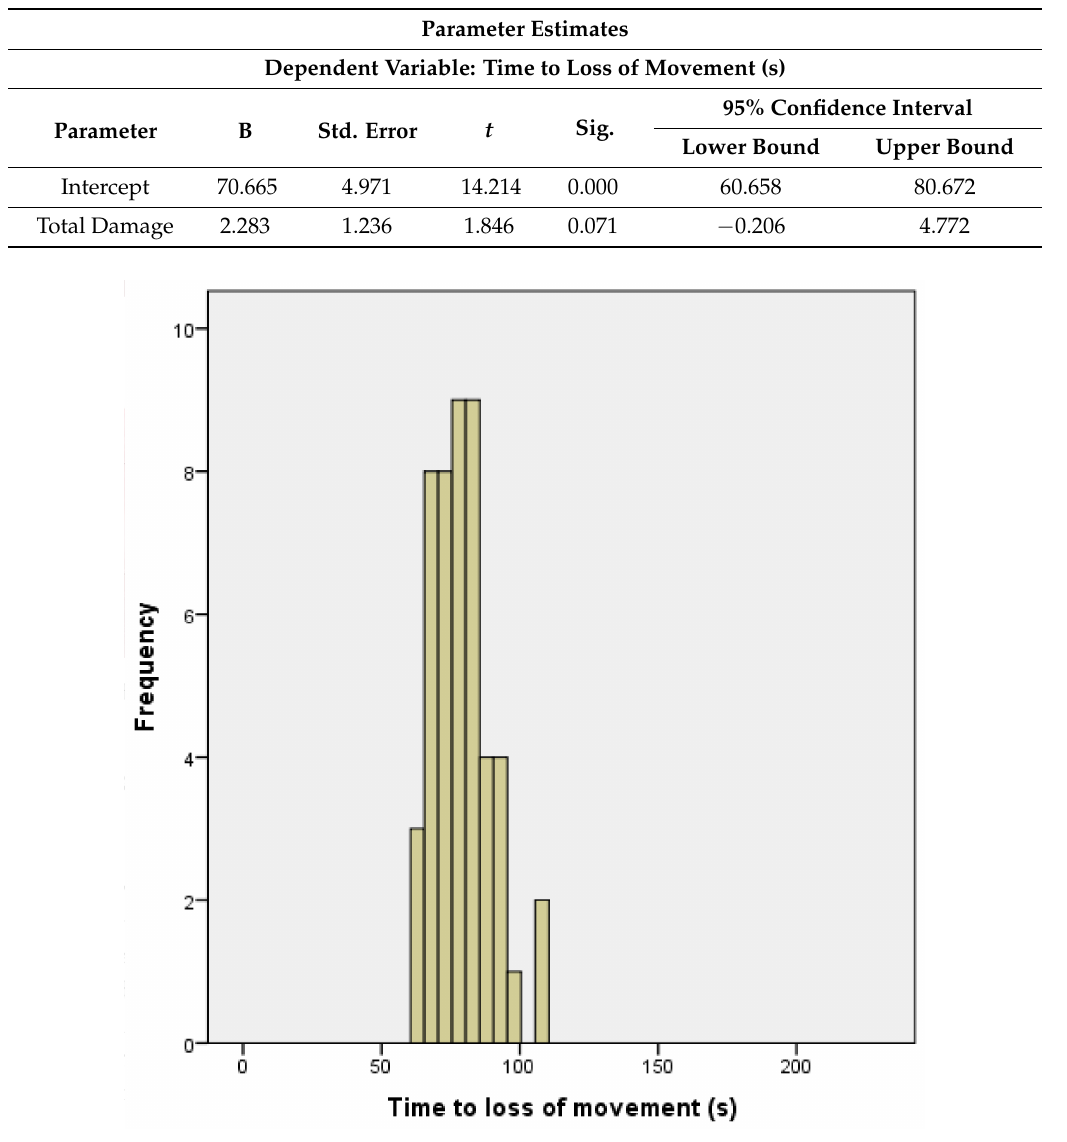
Figure 14. The distribution of time to loss of movement in lambs post-shot (mean = 79.42, SD = 10.657, n =